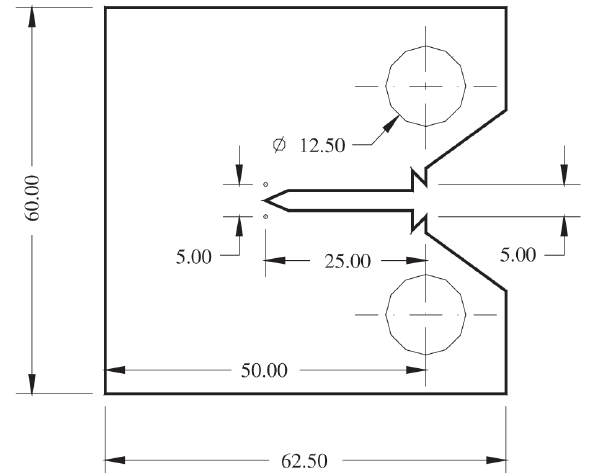
Figure 1. Schematic representation of ARALL laminates in 2/1 stacking. Figure 2. C(T) specimen